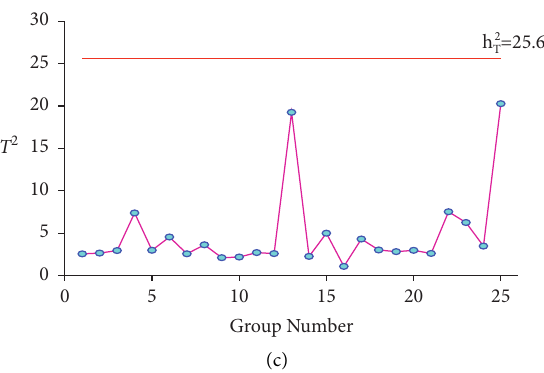
Figure 2: T 2 control chart and SPE control chart of catenary in normal states. (a) Principal component T 2 control chart; (b) SPE control chart; (c) conventional multiple T 2 control chart.